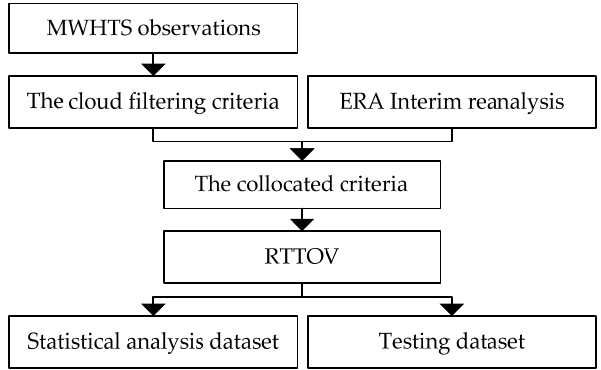
Figure 2. The flow chart for the MWHTS observations’ processing procedure.